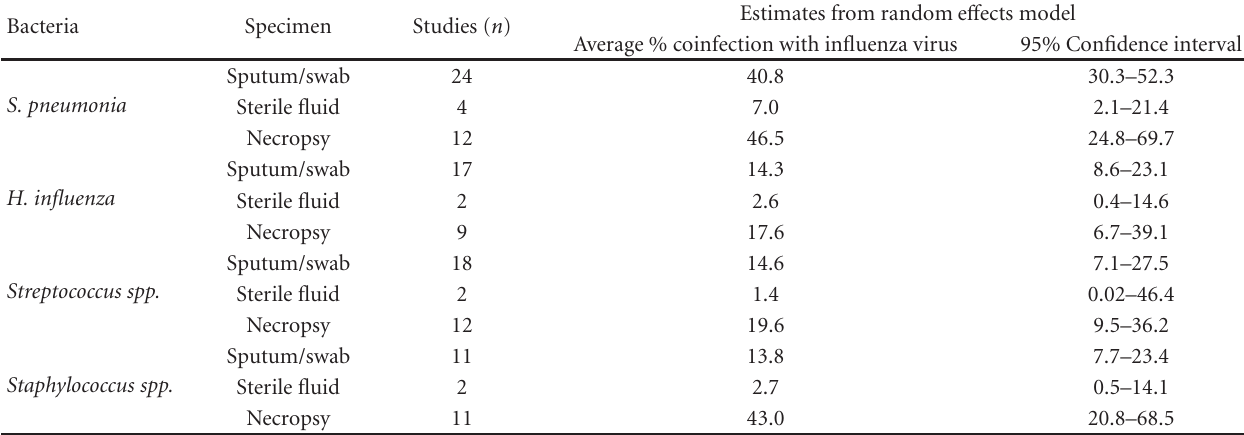
Table 4: Comparison of coinfection with major bacterial pathogens and influenza by specimen type during pandemic influenza periods a,b .